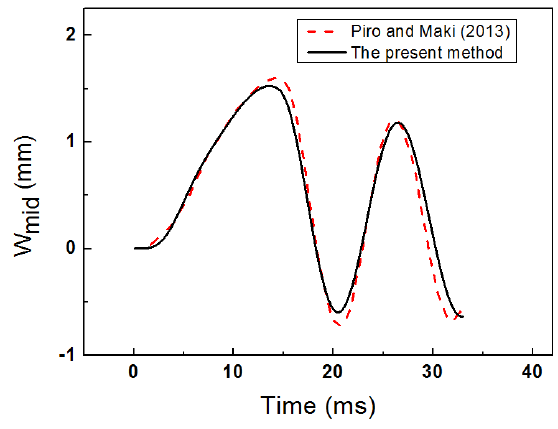
Figure 7. Comparison of the time-history deflection results at the center of the length L.